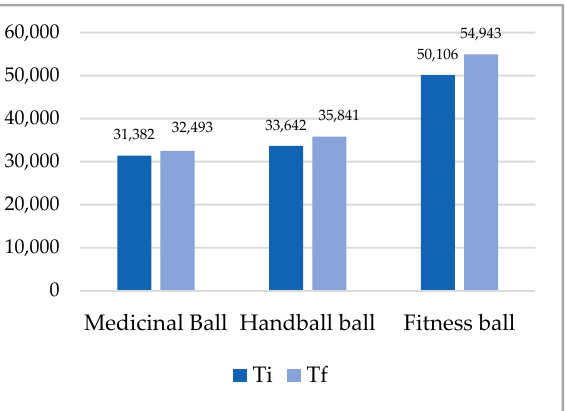
Figure 3. Mean of plank up test with 2 support points (arms, legs)—individual sports.